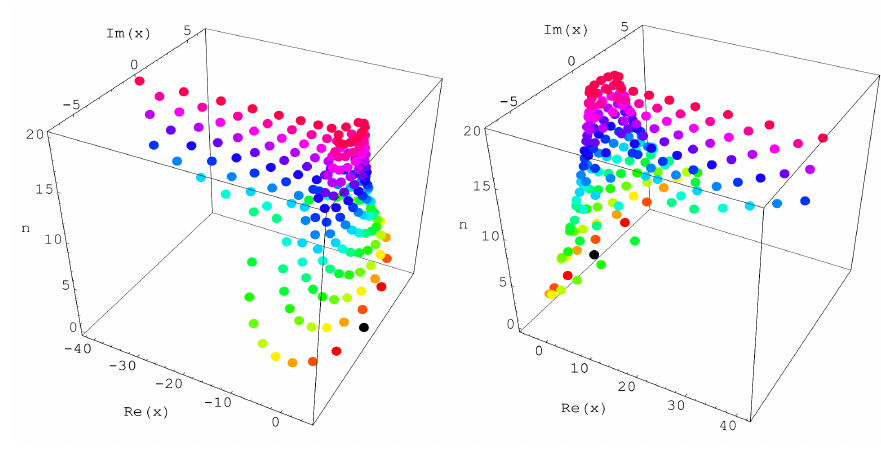
Figure 3. Stacks of zeros of G n ( x , r , β ) = 0,1 ≤ n ≤ 20.